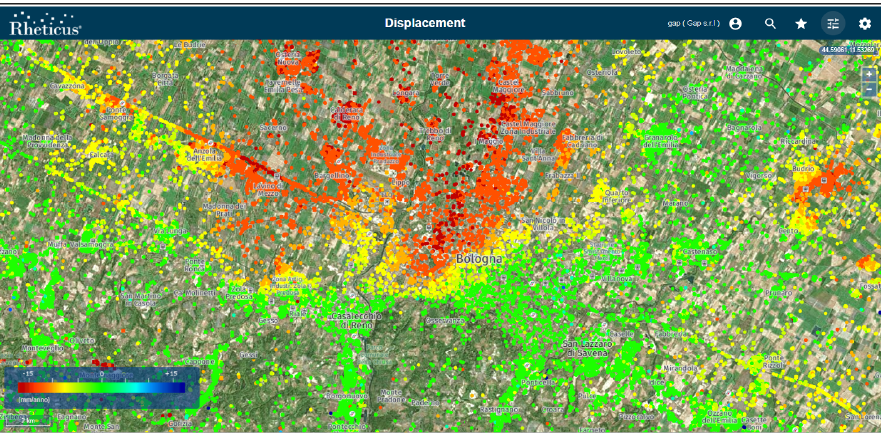
Figure A2. The displacement map obtained for the descending orbit.